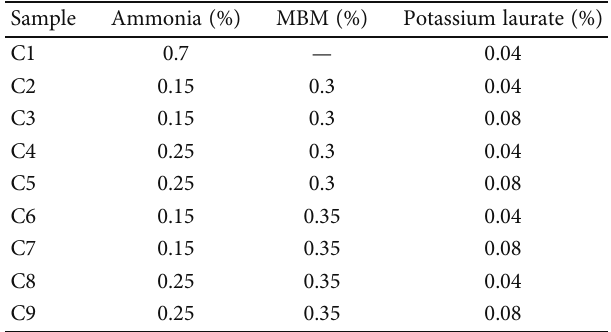
Table 1: Preservation formula of fresh NRL. Sample